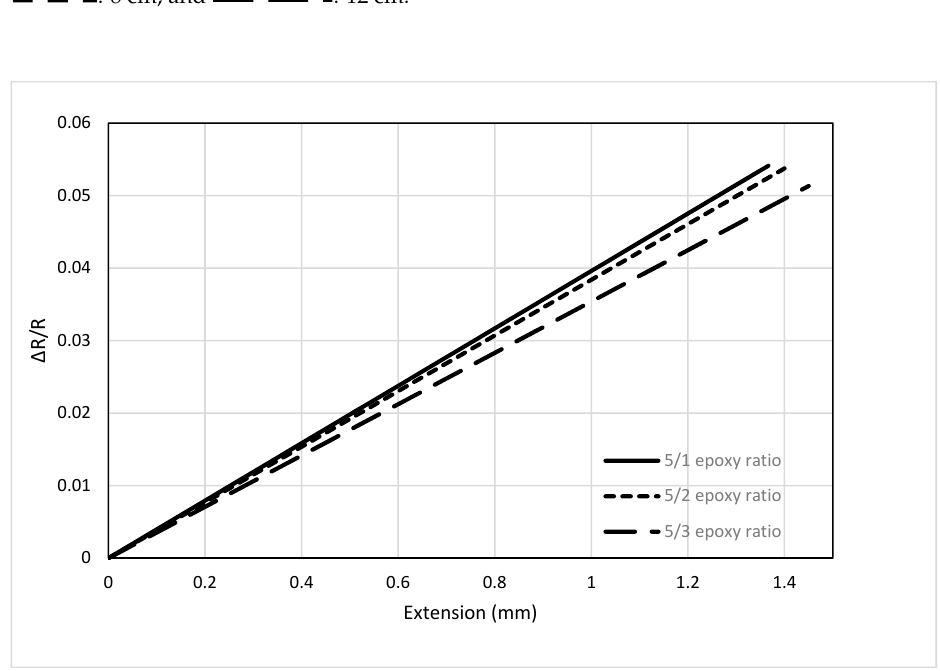
Figure 4. Stress–strain curve of fibers with different number of filaments: ( a ) 1 K, ( b ) 3 K, ( c ) 6 K and ( d ) 12 K; : bare fiber and : carbon fiber sensor.